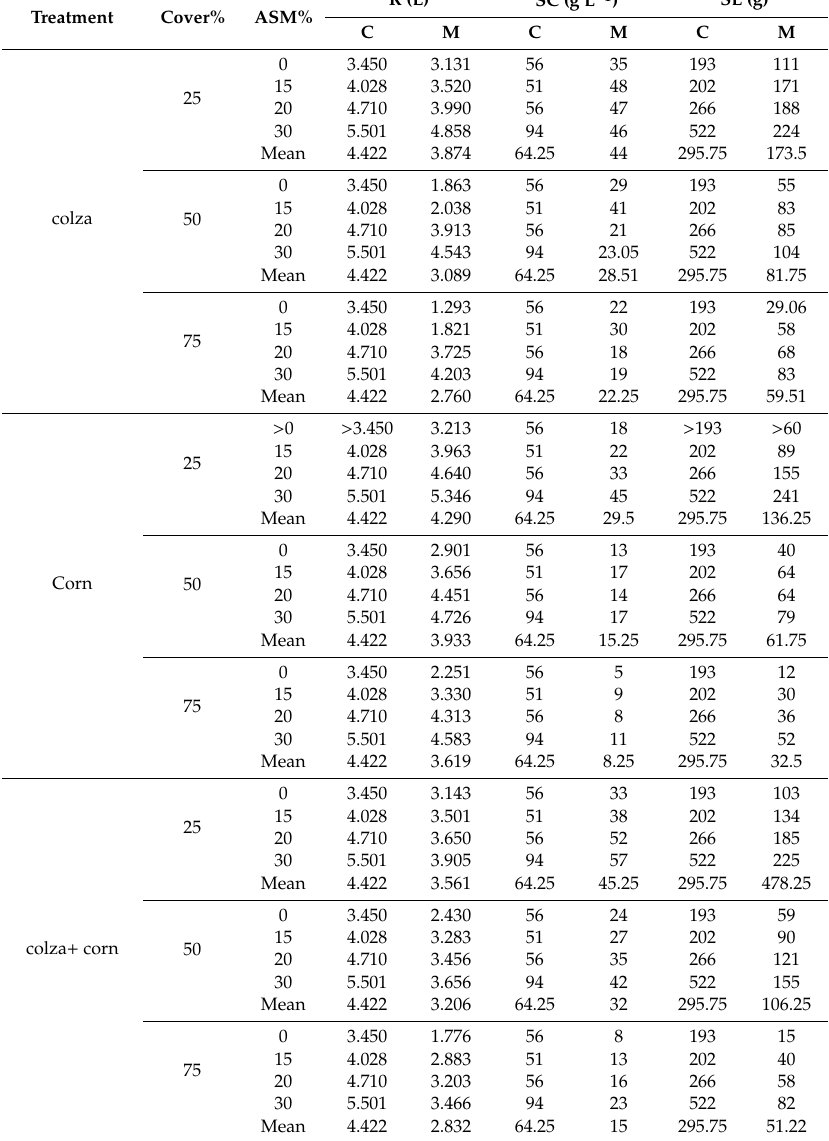
Figure 3. A view of the rainfall simulator at the laboratory of Sari University of Agricultural Sciences and Natural Resources.